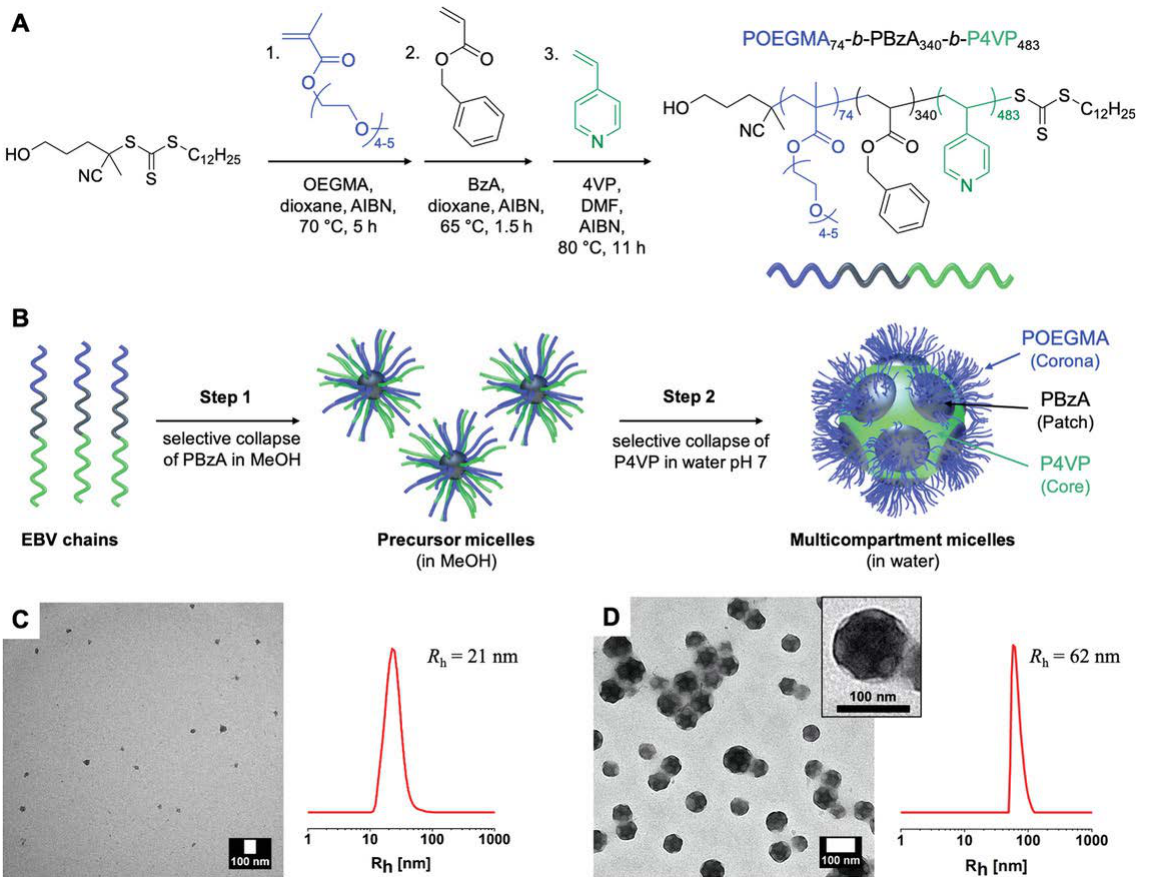
Figure 5. Synthesis of POEGMA-b-PBzA-b-PVP and self-assembly characterization. ( A ) reaction scheme involved in the preparation of the polymer and ( B ) step-wise formation of micelles and multi-compartment micelles. TEM and DLS measurements of polymers in ( C ) methanol and ( D ) in water at pH 7. Reprinted from ref.